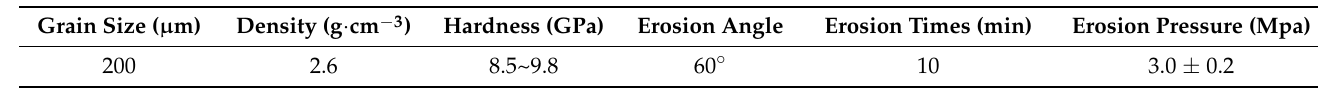
Table 4. Erosion experiment